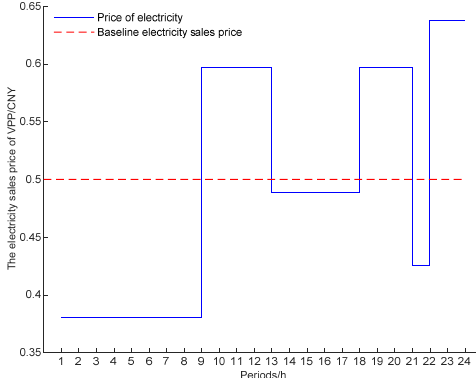
Figure 3. Optimal pricing strategy of the VPP.